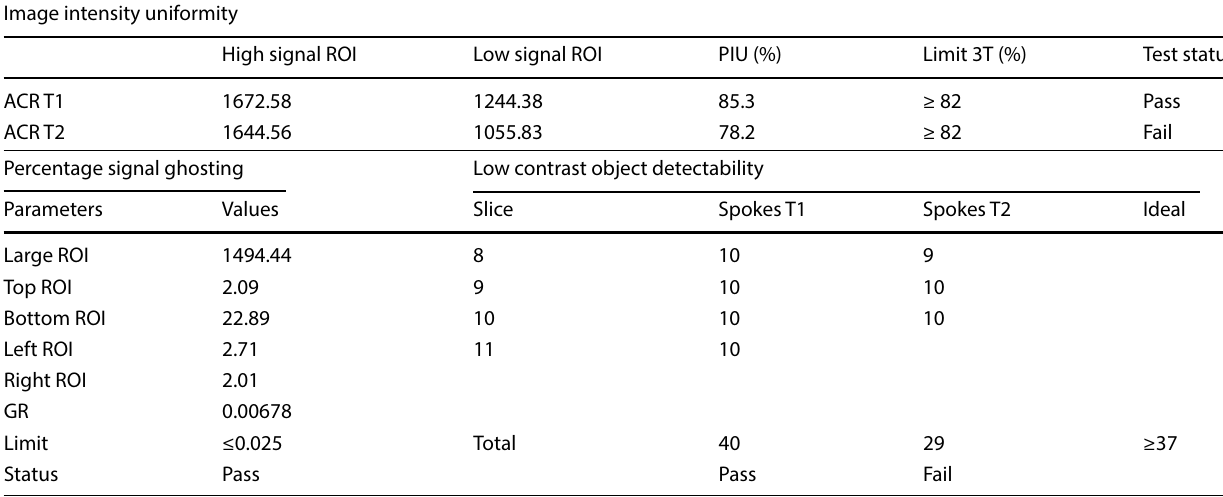
Table 4 Summary of results for image intensity uniformity, percentage signal ghosting, and low contrast object detectability on a 3.0 T Philips scanner Image intensity